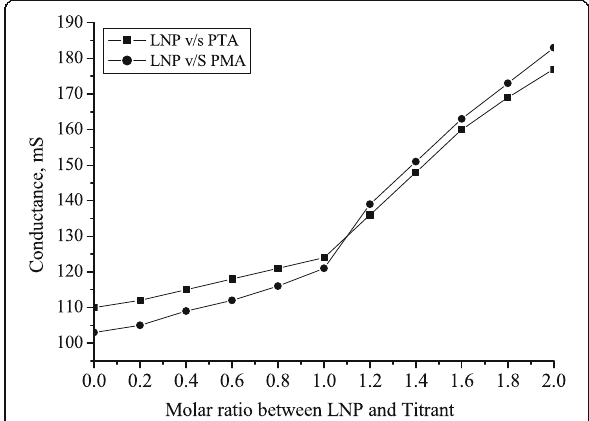
Fig. 2 Conductometric titration curves for titration of 10 ml of 0.01 mol l − 1 LNP with 0.01 mol l − 1 PTA or PMA